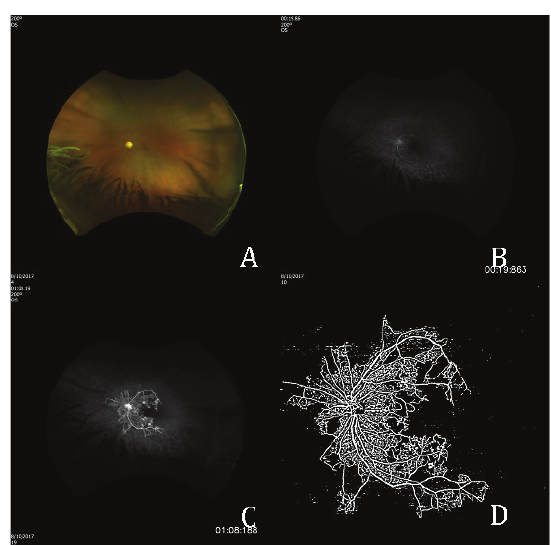
Figure 1. Color fundus photo, left eye (A) early (B) and late (C) fluorescein angiography of the left eye showing marked peripheral ischemia and posterior pole neovascularization. OCT angiography (D) showing severely decreased vascular